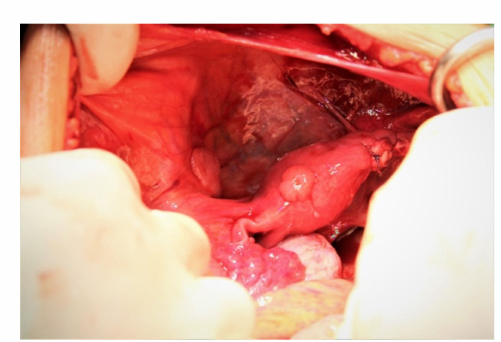
Figure 2. Uterine and pelvic peritoneal metastases of ovarian dysgerminoma (courtesy of Prof. G.